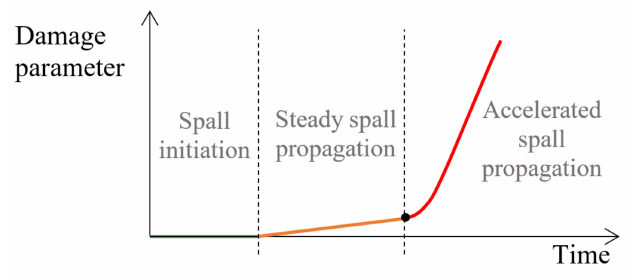
Figure 1. Typical failure process of a spall